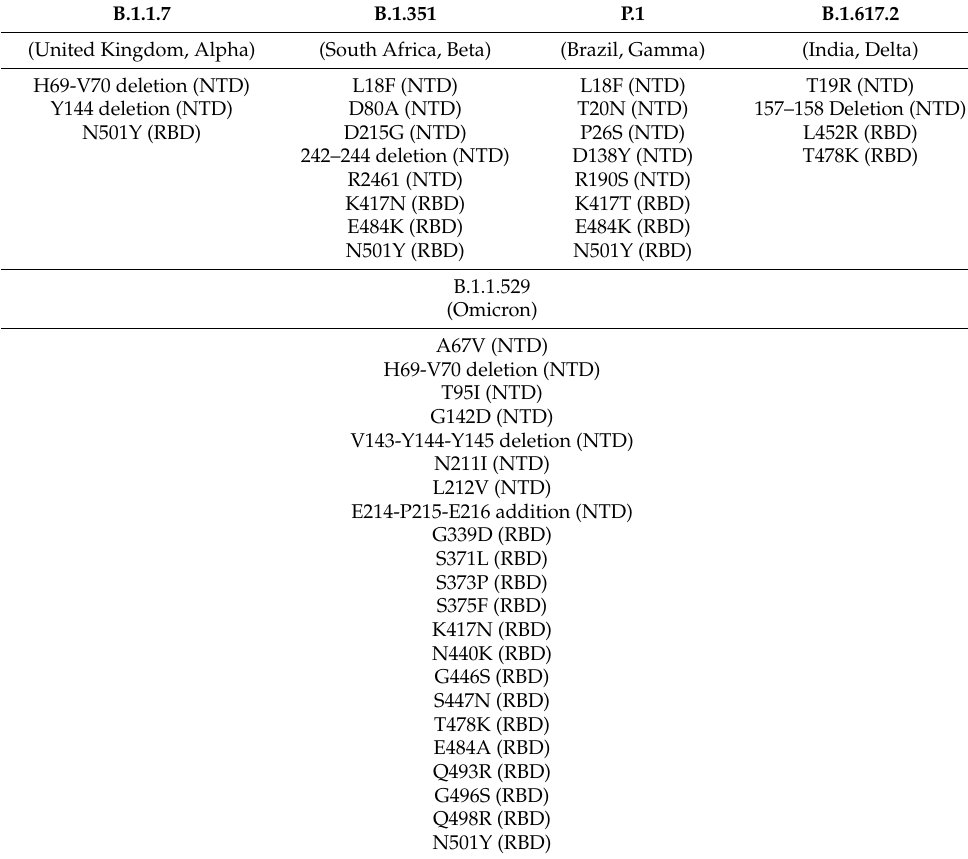
Table 1. The different mutations for selected SARS-CoV-2